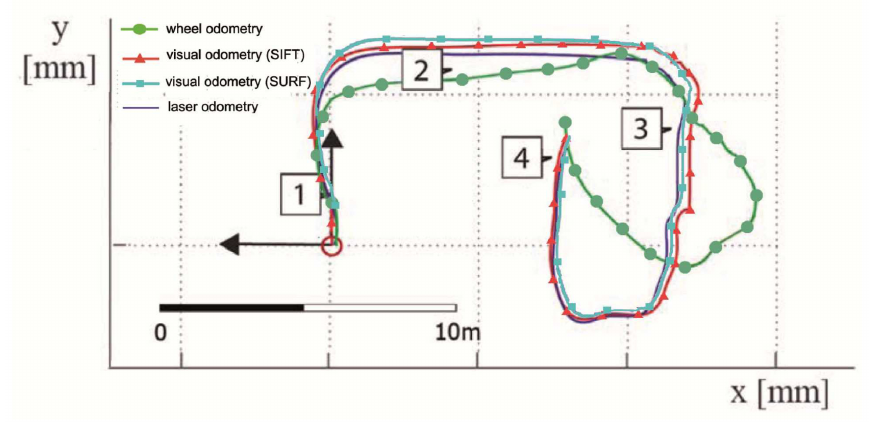
Figure 11. Trajectories estimated by visual (Harris, SIFT and SURF) and wheel odometry (black, red, cyan and green line, respectively) for the first test. Blue lines define the trajectory estimated by the laser scan matching. Robot poses at the captured times shown in Figure 10 are